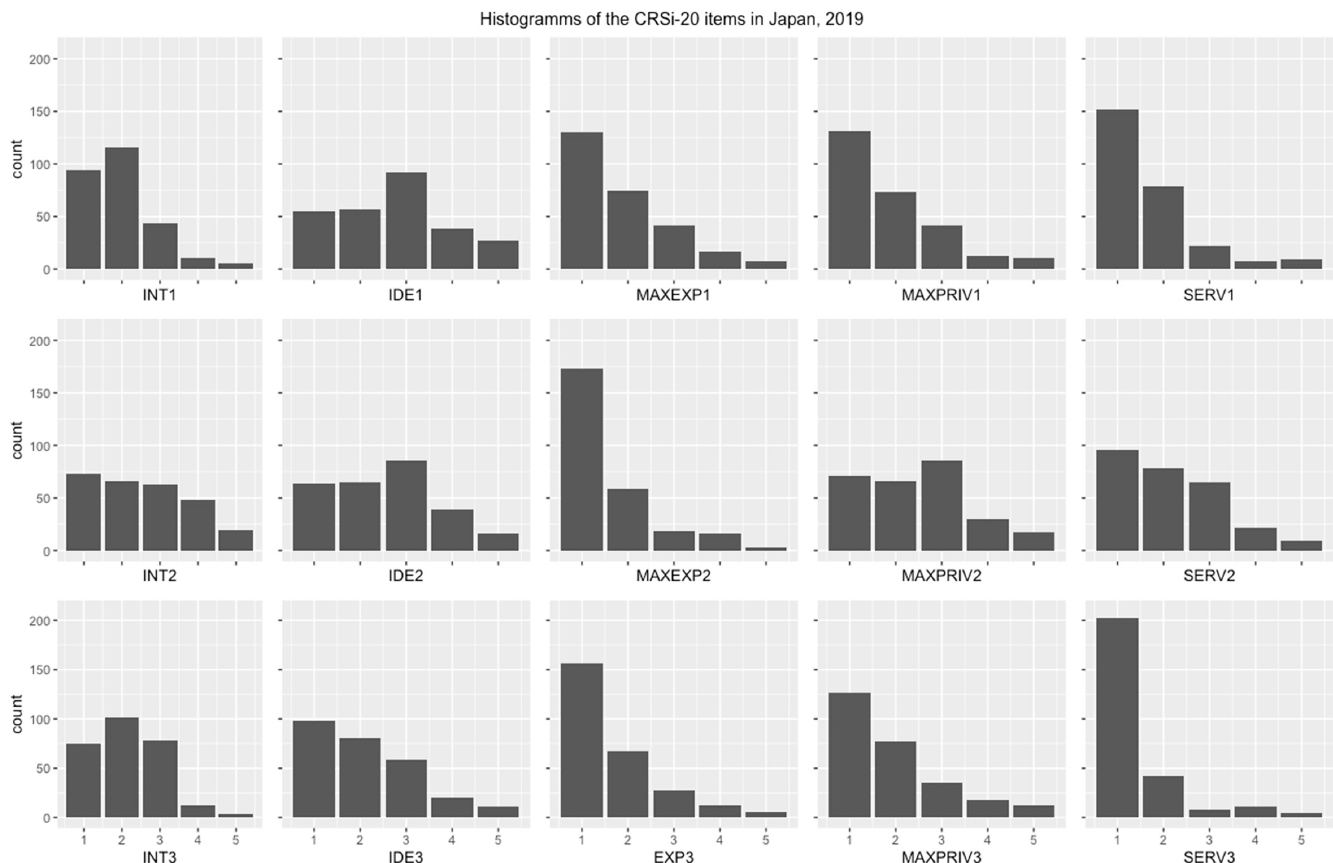
Figure A2. Histograms of CRSi-20 items. Int = intellect; ide = ideology; serv = public practice; priv = private practice; exp = experience; max = this prefix means that out of two items, only the one with the higher value for this core dimension is processed in the analysis. The number after the item name indicates the position of the item within the core dimension items. The upper row contains the items included in the CRSi-7, adding the middle row constitutes the items of the CRSi-14, and including the lower row you get all items of the CRSi-20.